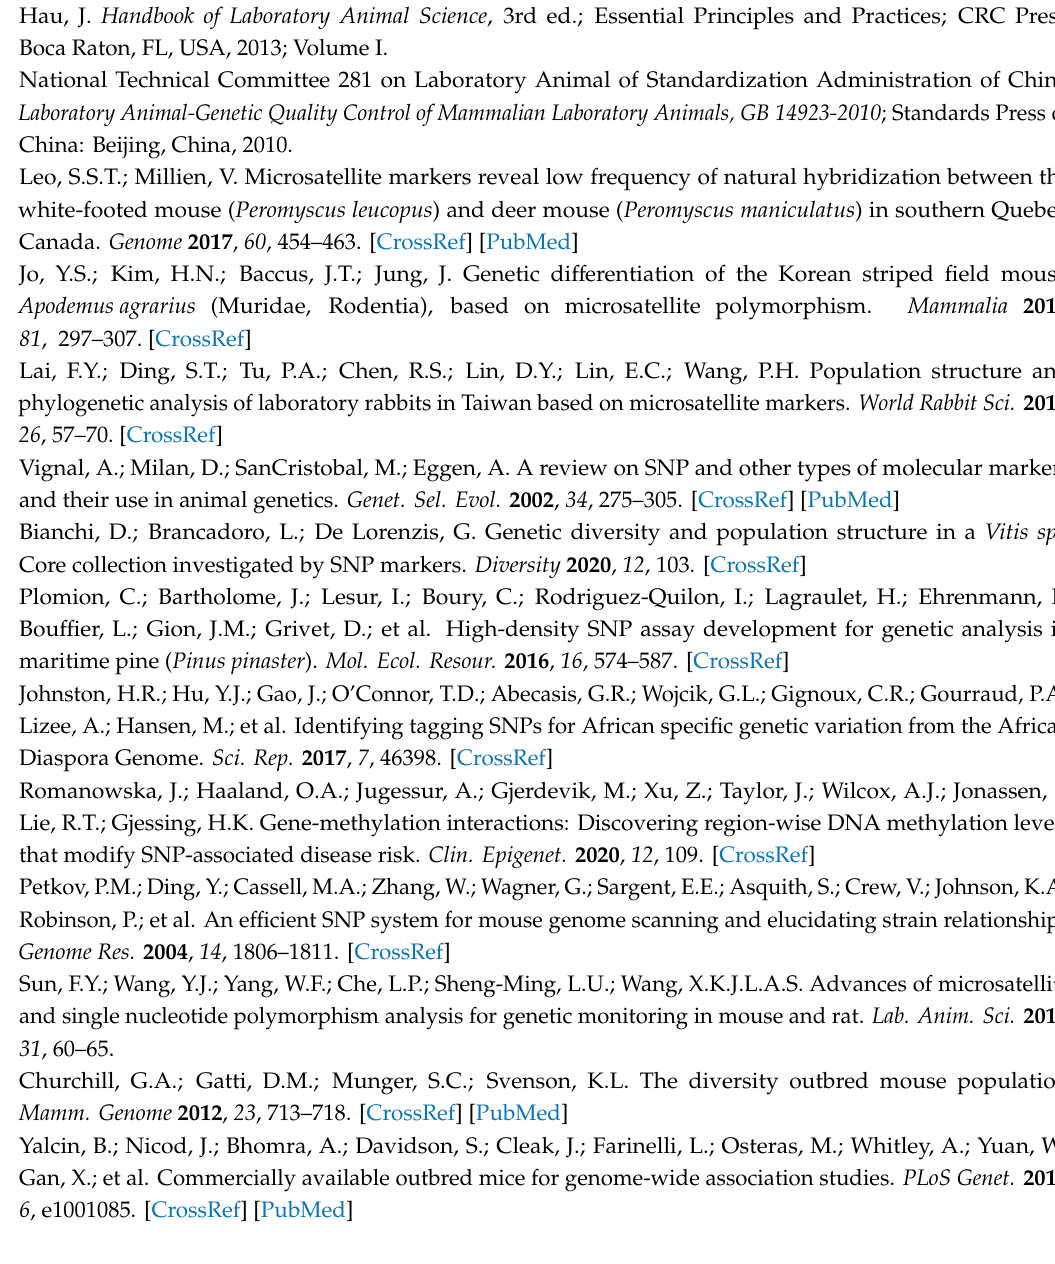
Figure S1: Frequency distribution of 51 SNPs in 29 sequences; Table S1: Characterization of 51 SNP markers in the rare